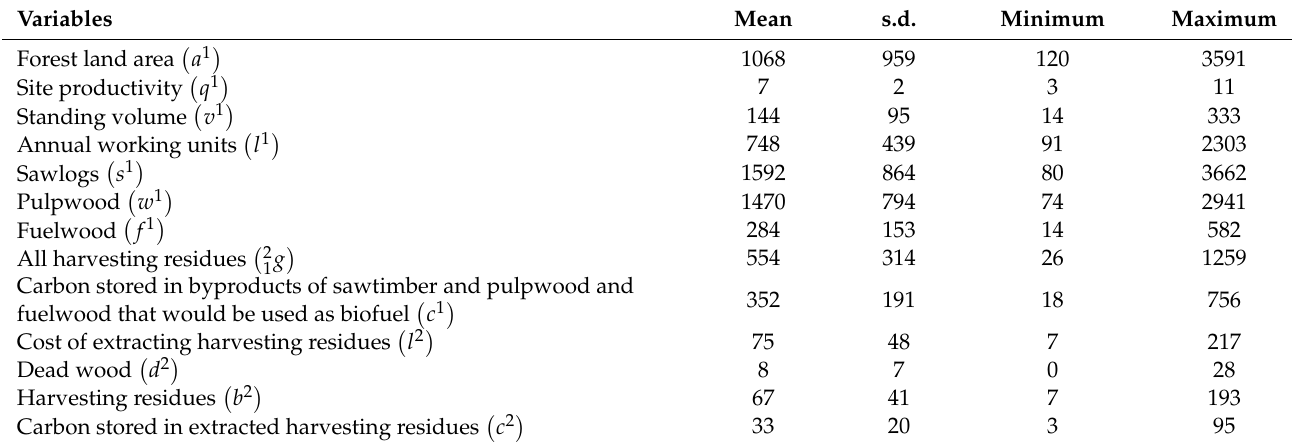
Table A2. Descriptive statistics of network DEA data aggregated over 20 counties and between 2008 and 2014. Variables